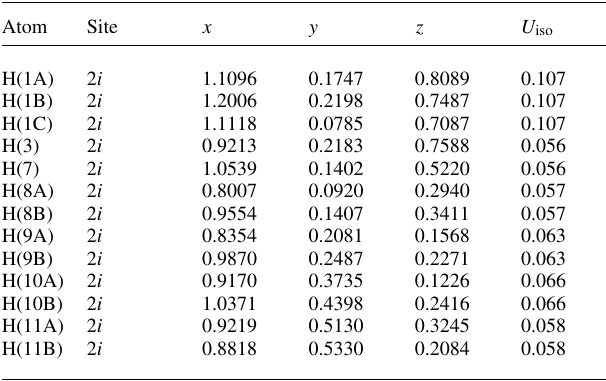
Table 2. Atomic coordinates and displacement parameters (in Å 2 )